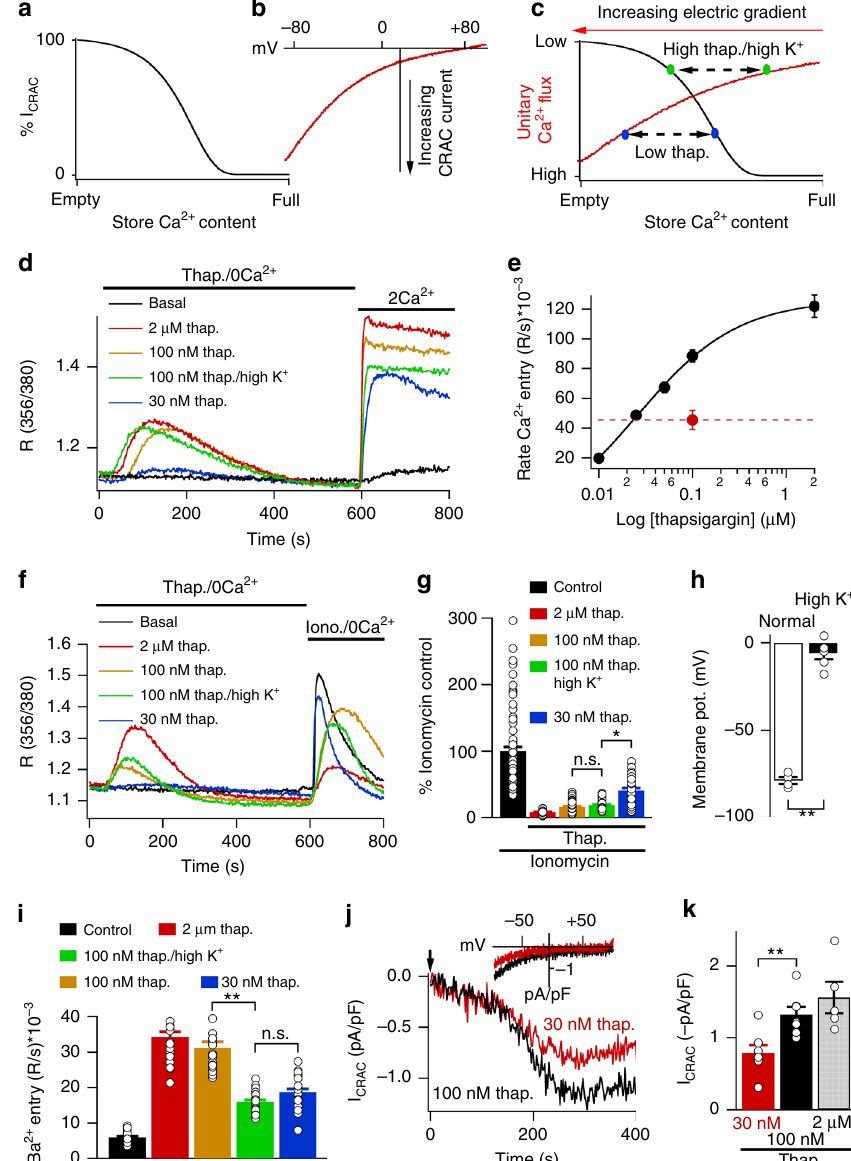
Fig. 1 Matching cytosolic Ca 2 + rises to low and high thapsigargin concentrations. a Schematic depicts the relationship between store Ca 2 + content and I CRAC activation, based on ref. 22 . It is included for demonstrative purposes only. b Current – voltage relationship for CRAC current from an RBL cell. Pipette solution contained 30 μ M InsP 3 and 10 mM EGTA to deplete the stores. c The graph combines panels a and b , to show the relationships between store depletion, electrical gradient and unitary Ca 2 + fl ux. d Ca 2 + release and Ca 2 + in fl ux are shown following stimulation with different concentrations of thapsigargin. Basal depicts cells exposed to the same solutions but without thapsigargin. e Graph compares the rate of rise of cytosolic Ca 2 + after readmission of external Ca 2 + following stimulation with different concentrations of thapsigargin. Each point is the mean of 11 – 17 cells. Basal rate was subtracted. Red dot indicates Ca 2 + entry rate to 100 nM thapsigargin in high K + solution. f Ionomycin (2 μ M)-evoked Ca 2 + release is compared between cells treated with different concentrations of thapsigargin. g Aggregate data from experiments as in panel f are compared. Control denotes cells that were not challenged with thapsigargin prior to ionomycin stimulation. Each bar is the mean of 44 – 82 cells. h Membrane potential is compared in cells exposed to standard (2.8 mM) K + or high (100 mM) K + solution, measured in current clamp mode. Each bar denotes data from eight cells. i Ba 2 + entry rate is compared for the conditions shown. Cells were stimulated with different concentrations of thapsigargin in Ca 2 + -free solution and then 2 mM Ba 2 + was applied. Each bar is the mean of between 22 and 31 cells. j Whole-cell patch clamp experiments compare I CRAC following activation with 30 nM or 100 nM thapsigargin. Thapsigargin was applied at the arrow. Inset compares I – V relationships (taken when the currents had peaked) for the two stimuli. k Bar chart compares mean data for the conditions shown. Thirty nanomolar and 100 nM bars are the mean of seven cells each and 2 μ M is the mean of fi ve cells. *denotes p < 0.05, ** p < 0.01 and n.s. not signi fi cant, determined using unpaired Student ’ s t -test. Error bars denote SEM 30 nM thapsigargin led to ~2-fold less store depletion (Fig. 1g). One-hundred nanomolar thapsigargin in high K + solution, therefore, evokes greater store depletion than 30 nM thapsigargin in standard K + solution. NATURE COMMUNICATIONS| (2019) 10:2516